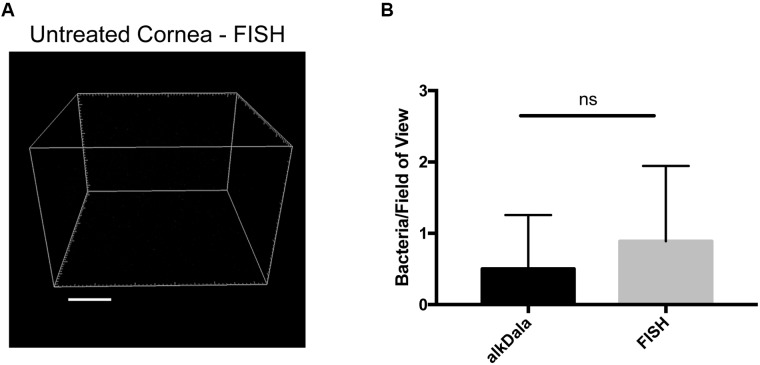
Fluorescence in situ hybridization (FISH) labeling confirms that healthy murine corneas are nearly devoid of viable bacteria. (A) FISH labeling confirmed C57BL/6 mouse corneas host very few viable bacteria. A representative field of view is shown from four different corneas (two male and two female mice). (B) Quantification of viable bacteria on healthy murine corneas using alkDala or FISH expressed as mean ± SD per field of view. One field of view is ∼0.04 mm2. ns = there was no significant difference between number of bacteria detected by either method (P = 0.40, Student’s t-Test).